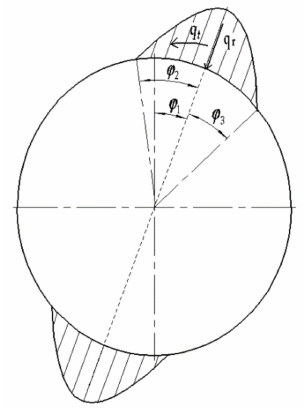
Figure 8. External load distribution of FS of the HD with a conventional